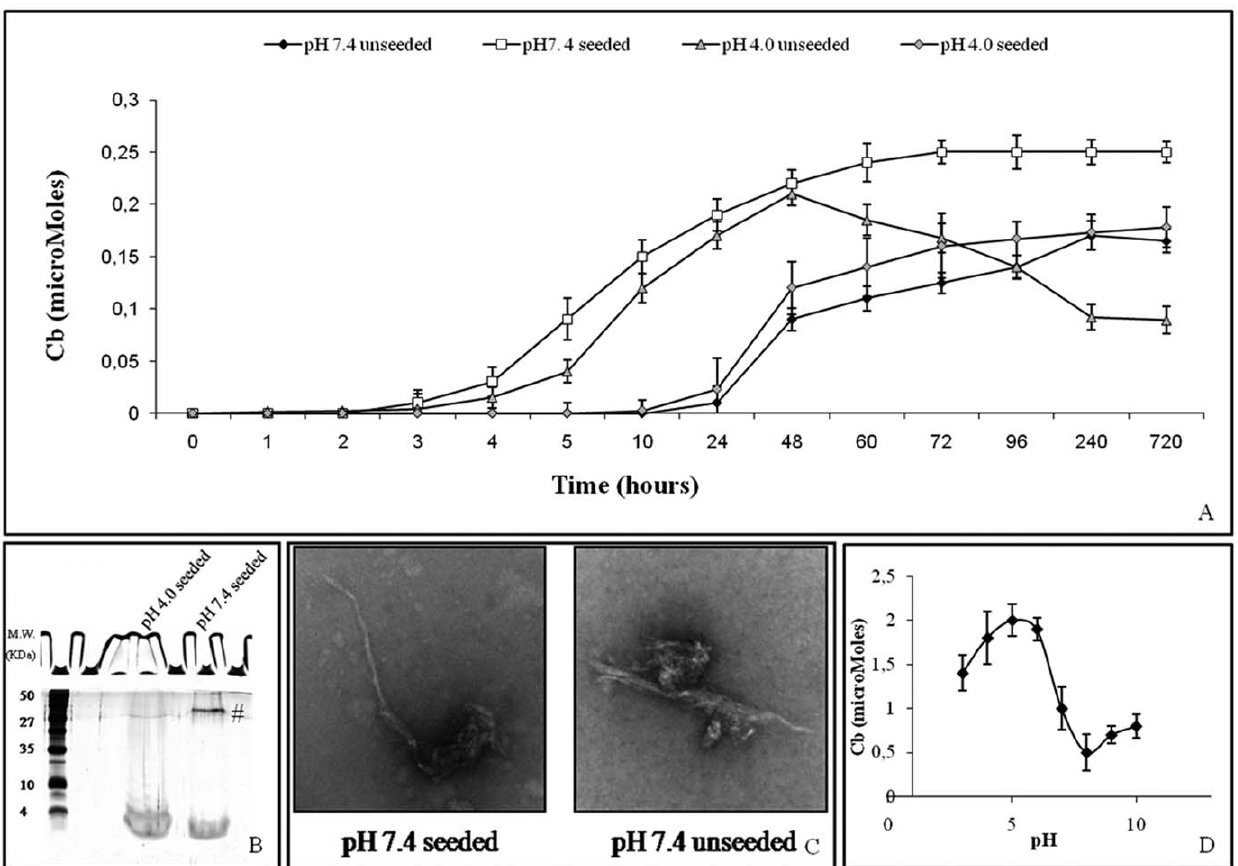
Figure 3. Seeding. A ) Seed-inducedfibrilformationof a -ANP . Seeds were generated from aged a -ANP (pH 7.4 and pH 4.0, respectively) and added as percentage weight fractions. Fibril formation was monitored over time by Cb and TEM. B ) Treatmentin90%HFIPofANPaggregates formedafterseeding . High MW aggregates from pH 4.0 seeded solution remained on the top of the gel while aggregates formed by pH 7.4 seeds were monomerized. C ) Morphologyofsamplesagedfor720hours. Morphologies of seeded and unseeded a -ANP at pH 7.4 were still similar in shape. D ) pHdependenceof a -ANPaggregation. a -ANP was incubated at various pH and after two days the amount of aggregation was quantified by Cb.